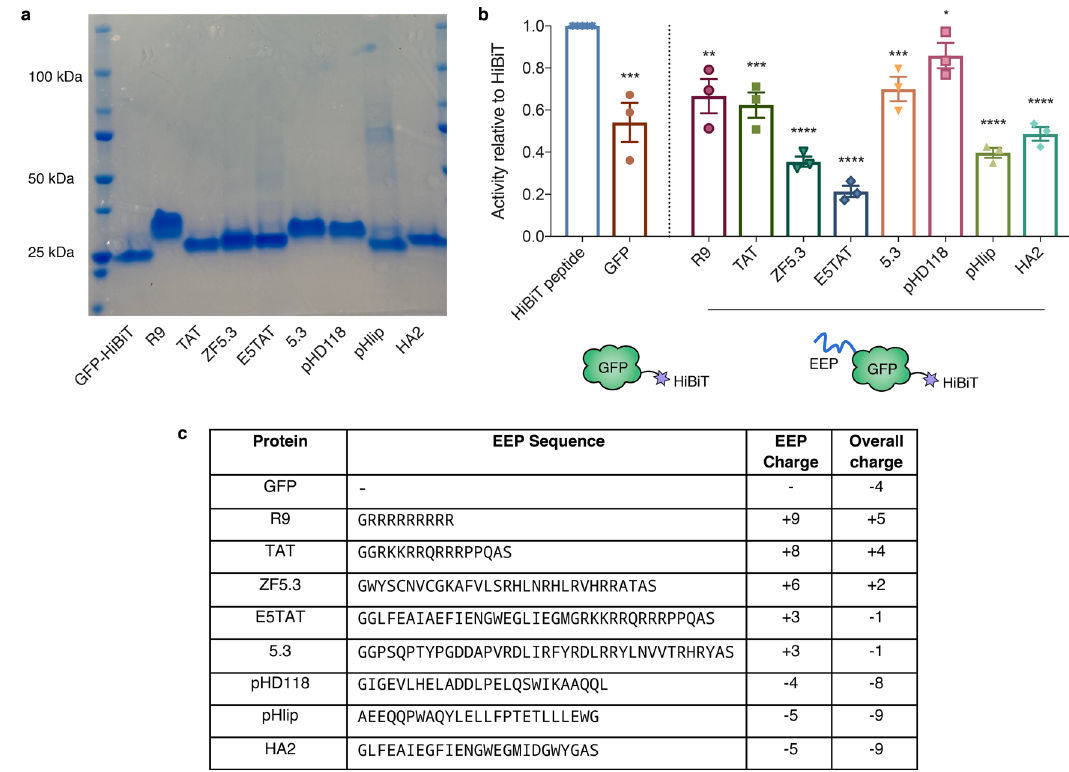
Fig. 3 HiBiT fused to EEP-modi fi ed GFP retains luminescent activity. a SDS-PAGE gel of EEP-GFP-HiBiT fusion proteins. n = 3 independent experiments b Luminescent activity of EEP-GFP-HiBiT relative to HiBiT peptide (activity of HiBiT normalised to 1). For simplicity in naming, EEP-GFP-HiBiT fusion proteins are labelled by the EEP. Data represents mean ± SEM, n = 3 independent experiments. Two-tailed unpaired t test was used to analyse the data. * p ≤ 0.05, ** p ≤ 0.01, *** p ≤ 0.001 and **** p ≤ 0.0001. c Summary of EEP peptide sequences, their respective charges and the overall charge when fused